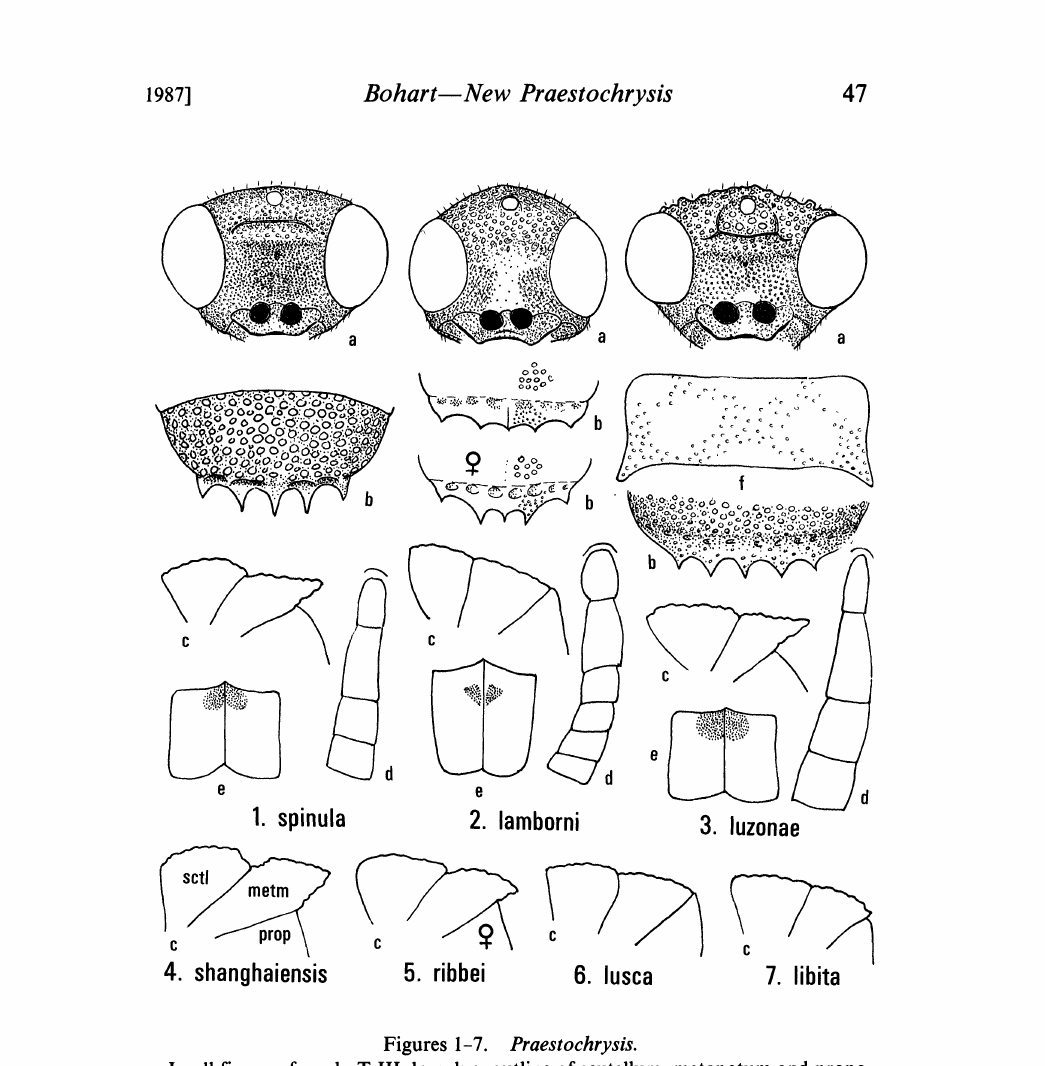
Figures 1-7. Praestochrysis. In all figs.: a, face; b, T-III dorsal; c, outline of scutellum, metanotum and propo- deum, lateral; d, petiole and basal flagellomeres; e, sternum II; f, pronotum, dorsal; sctl, scutellum; metm, metanotum; prop, propodeum. Figures not drawn to scale, 2b and 5c are based on females, other figures based on males, those of 1-3 are from